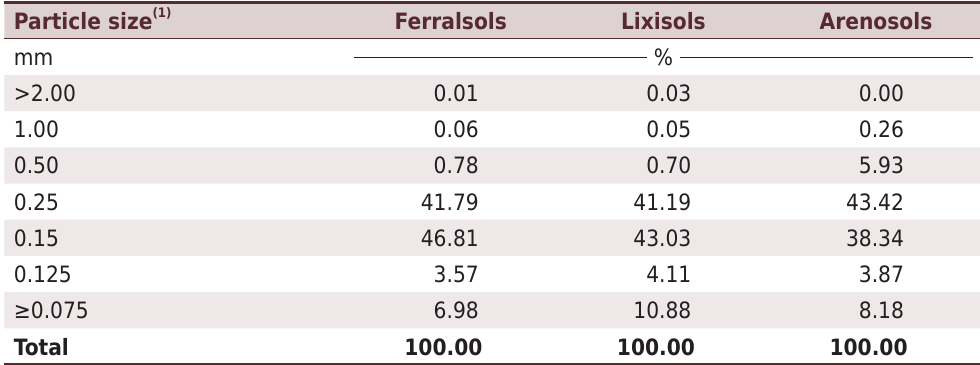
Table 3. The soil particles detached in percentage by raindrop according to soil type Particle size